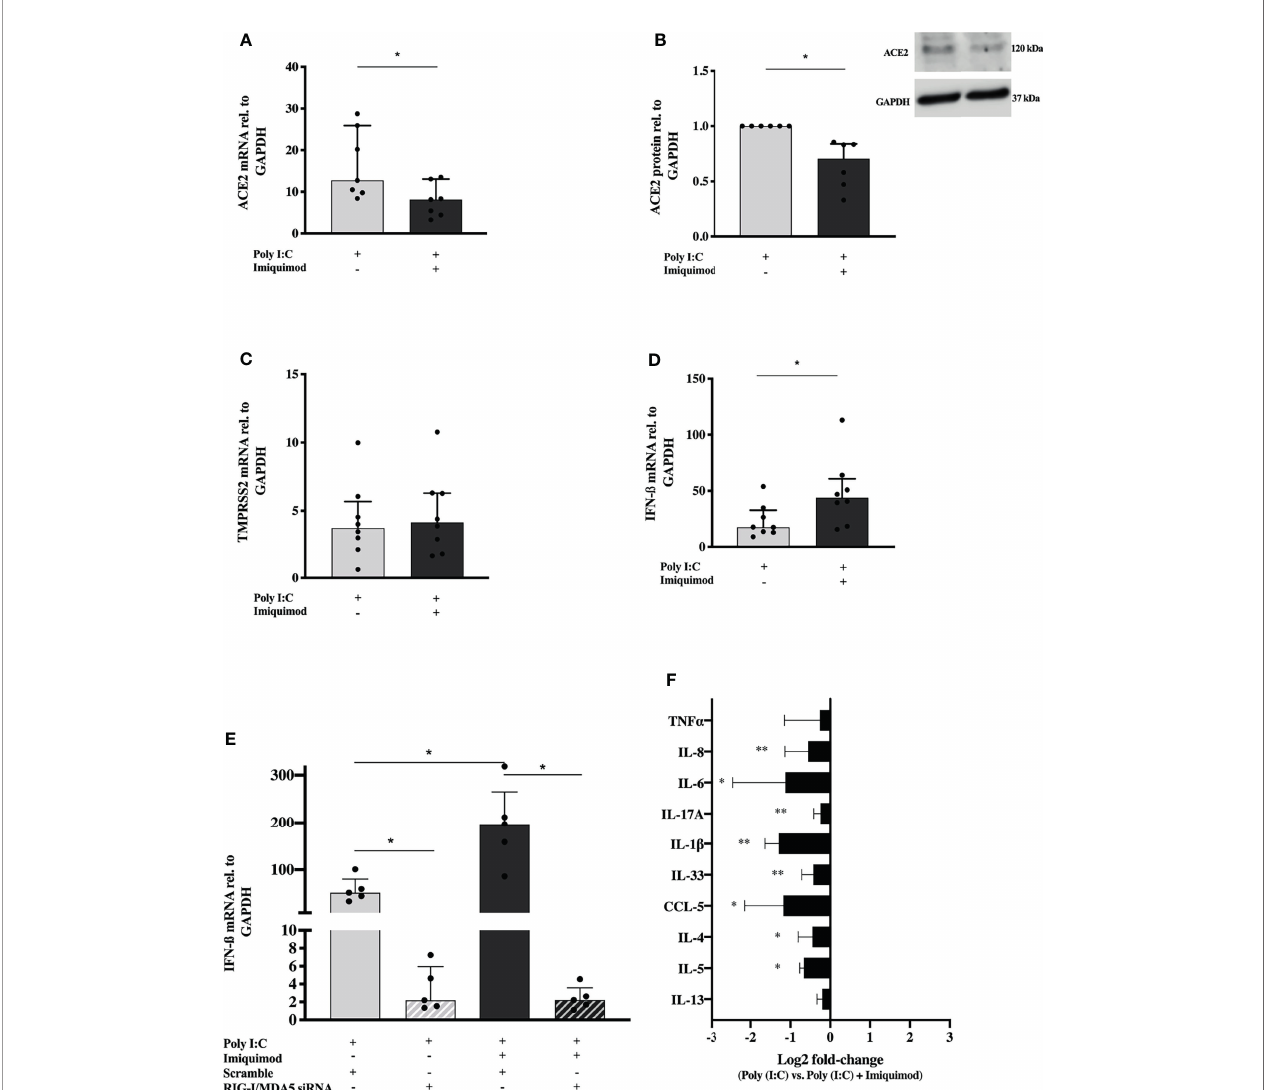
FIGURE 5 | Imiquimod decreases the expression of ACE2 receptor, and several pro-in fl ammatory cytokines in response to poly(I:C) stimulation, but increases the IFN response in human bronchial epithelial cells (HBECs) from asthmatics. ACE2 expression in HBECs from patients with asthma after treatment with poly(I:C) alone or in combination with imiquimod at gene (A) and protein (N = 6) (B) level. TMPRSS2 (C) , and IFN- b (D) mRNA expression in HBECs from asthmatic subjects in response to poly(I:C) or in combination with imiquimod. (E) Imiquimod effect on poly(I:C)-induced IFN- b mRNA expression in HBECs after siRNA-mediated downmodulation of MDA5 and RIG-I expression (N = 5; RM one-way ANOVA followed by Holm-S ̌ ı ́ da ́ k ’ s post hoc test). (F) Log2 fold-change [poly(I:C) vs . poly(I:C) + imiquimod] expression of several pro-in fl ammatory mediators in cell culture supernatants from HBECs after 24 hours poly(I:C) and imiquimod treatment, measured by multiplex ELISA (Luminex). Asthma (study population 2), N = 7-9 unless otherwise is expressed. Wilcoxon matched-pairs signed rank test for comparisons between two different treatment conditions. *p < 0.05; **p <